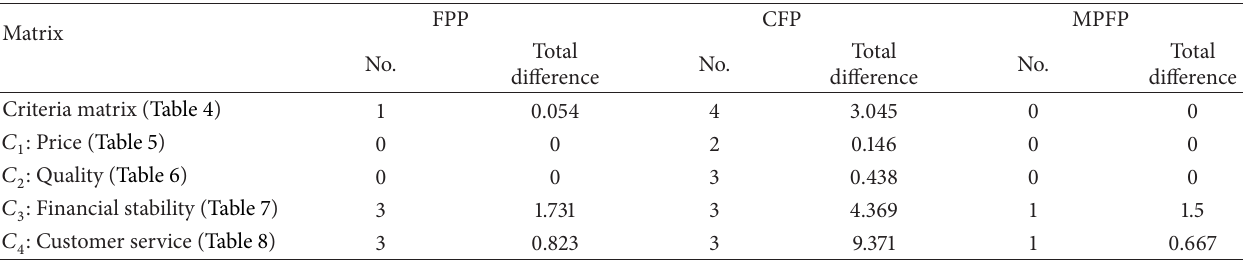
Table 9: Comparisons of FPP, CFP, and MFP methods (Example 1).